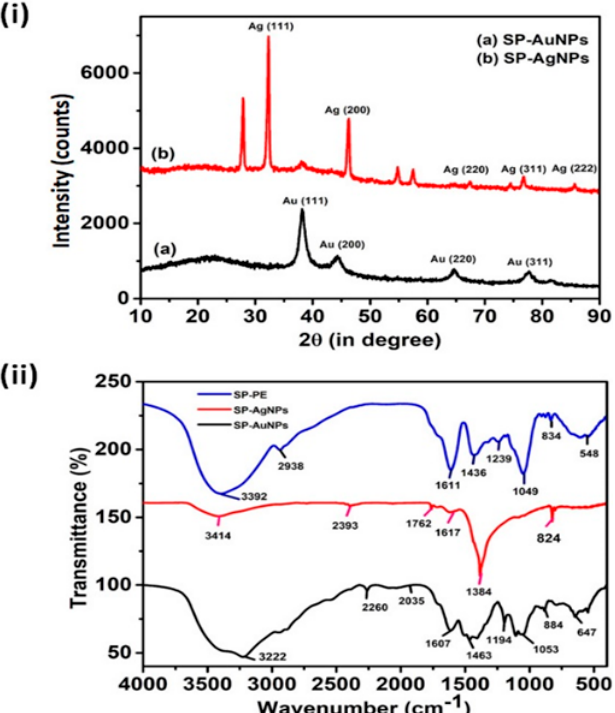
Figure 5. ( i ) Powder X-ray diffraction patterns of SP-AuNPs and SP-AgNPs. ( ii ) FT-IR spectra of SP-AuNPs, SP-AgNPs, and SP extract indicating functional groups in the plant extract and nanoparticle samples.